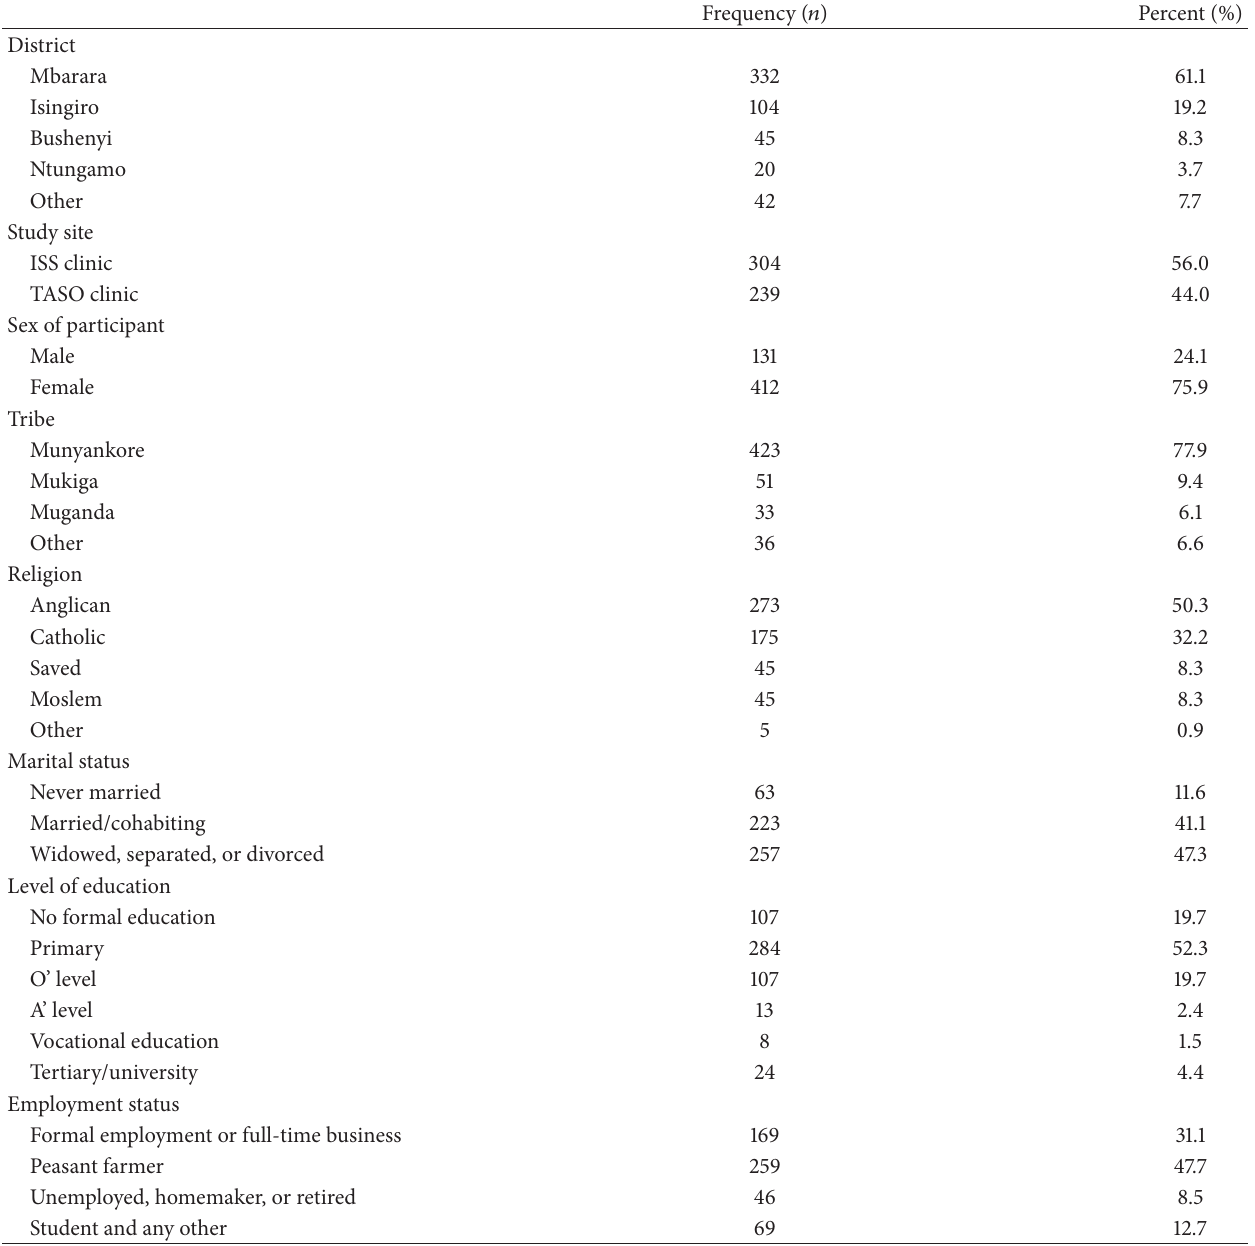
Table 1: Demographic characteristics of participants ( 𝑁 = 543